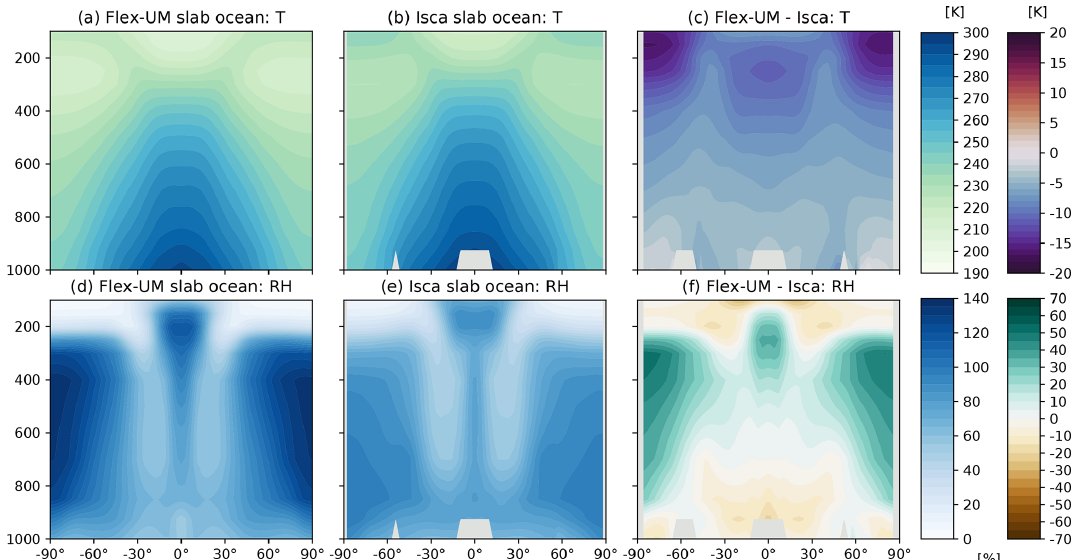
Figure 3. Slab-ocean aqua-planet model climatologies for Flex-UM (a, d) and Isca (b, e) for temperature ( T in K, a, b, c ) and relative humidity (RH as a %, d, e, f ) on their native model grids. The differences between the models (Flex-UM – Isca) is plotted in panels (c, f) and are interpolated onto the Flex-UM grid. Grey masking near the surface in the middle and right plots (b, e; c, f) occur where the Isca surface pressure is lower than the interpolated model level.